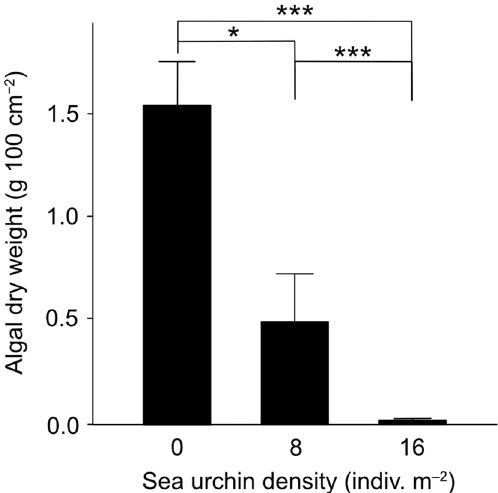
Figure 3. The effect of three density conditions of Diadema savignyi on algal biomass at the end of the 3-month experiment. Average + SE are shown. Stars denote statistical significance at p < 0.05 (*) and p < 0.001 (***).